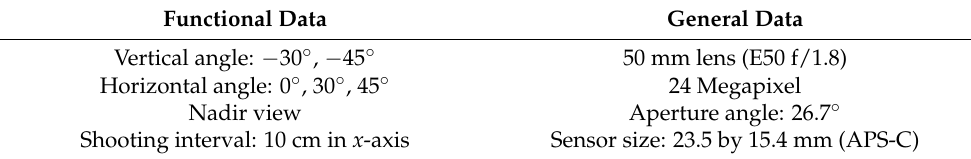
Table 1. Camera acquisition and specification